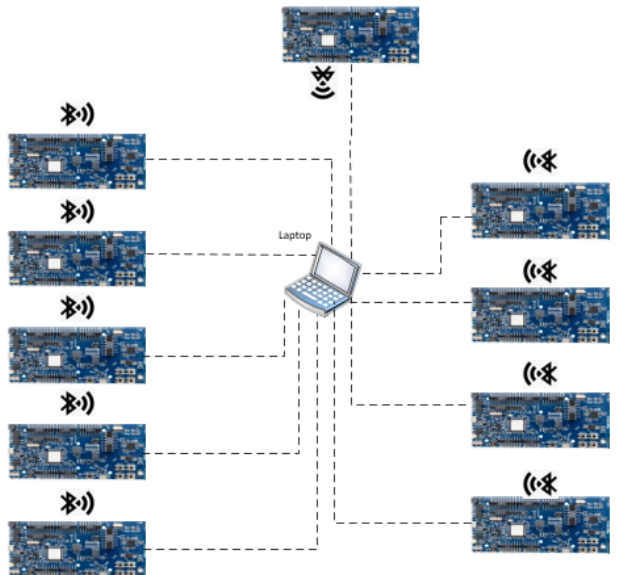
Figure 2. Testbed setup showing the USB links used for the experiment configuration and data collection.